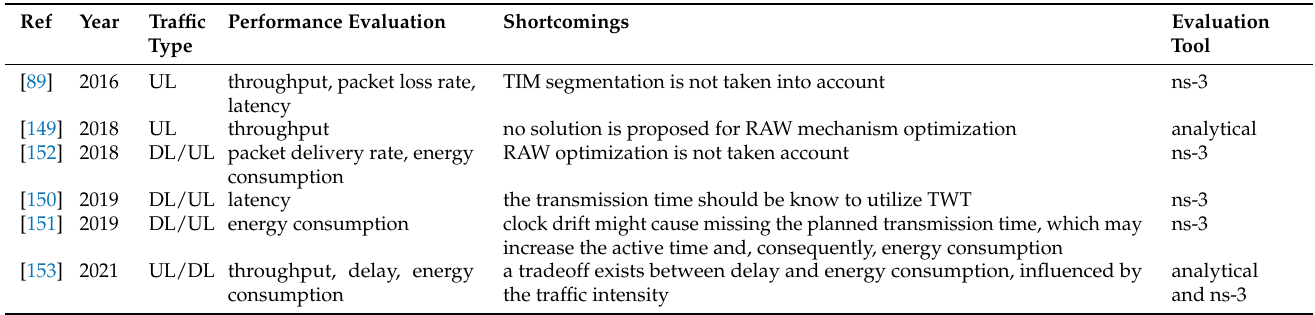
Table 9. Current solution concerning TWT with